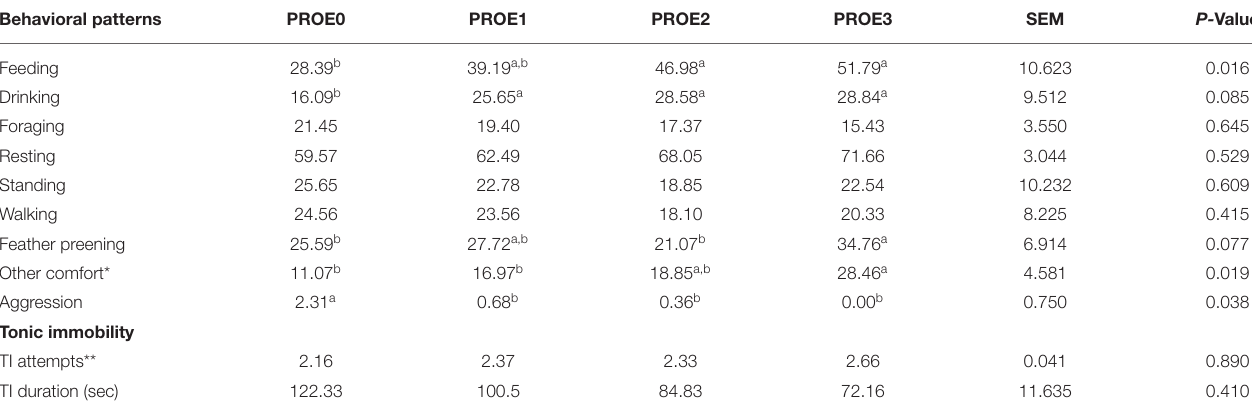
Tonic immobility